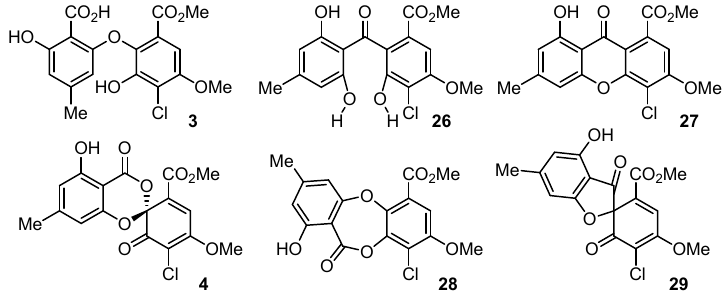
Figure 2. The chemical structure of pestheic acid, maldoxin, and these related natural compounds. In 2012, Yu and Snyder reported the first total synthesis of pestheic acid and maldoxin based on a biosynthetic pathway (Scheme 4) [28]. The synthesis was initiated with a known six-step conversion of methyl 3,5-dihydroxybenzoate to salicylaldehyde 30 . Site-selective methylation followed by chlorination [29–31] using SO 2 Cl 2 and 2,2,6,6-tetramethylpiperidine (TMP) afforded 3-chlorosalicyladehyde 31 (58% yield) and 5-chloride (15% yield). The use of a bulkier amine is essential because an undesired 5-chlorination was preferred when using t -butylamine (3-Cl:5-Cl = 1:2.6). After the MOM protection, the lithiated orcinol derivative 33 [32] was added to aldehyde 32 to produce alcohol 34 in 92% yield. Oxidation with Dess–Martin periodinane (DMP) gave benzophenone 35 in 90% yield. Over-reduction during the reductive removal of the benzyl group caused several issues. Various catalysts and reaction times were investigated, and reduction using the Rosenmund catalyst selectively afforded alcohol 36 . The resulting primary alcohol was converted to methyl ester 37 via a conventional three-step transformation. The removal of the MOM groups using TsOH produced chloroisosulochin 26 . Oxidation with K 3 Fe(CN) 6 [33–35] in H 2 O followed by continuous acidic hydrolysis furnished maldoxone 28 . The basic hydrolysis of 28 achieved a total synthesis of 3 . The oxidative dearomatization of 3 with iodobenzene diacetate (PIDA) afforded racemic 4 in 31% yield. The observed melting point of synthetic 4 is 193 °C, while that of natural 4 reported in the literature is 143 °C [4], indicating that the natural maldoxin is not racemic.